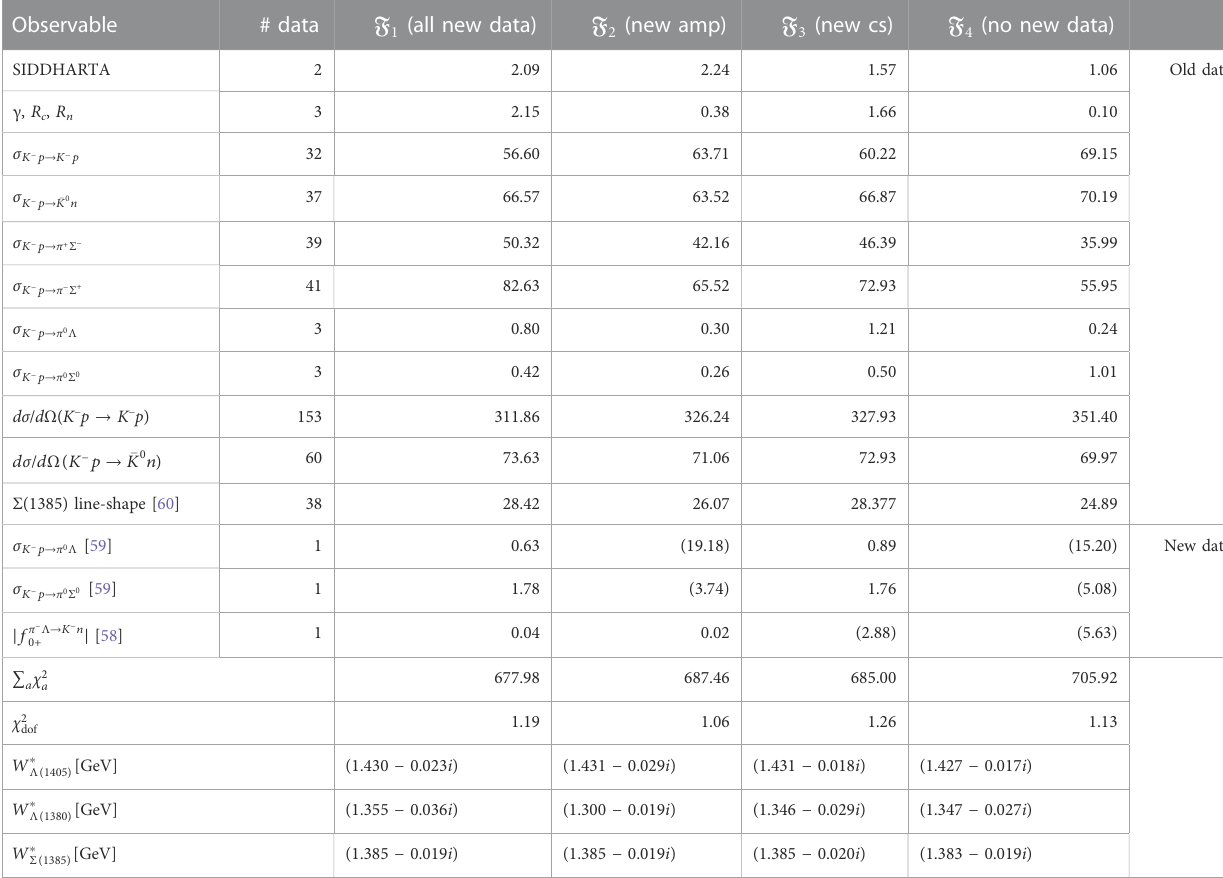
TABLE1Individualandtotal χ 2 forthe fi tstrategy F 1 , ... , F 4 .Theindividualcontributionstothe χ 2 arethe χ 2 observables (not included in χ 2 ) are put in parentheses. Bottom part of the table collects the predicted pole positions W * ∈ C . Uncertainties on pole positions are shown